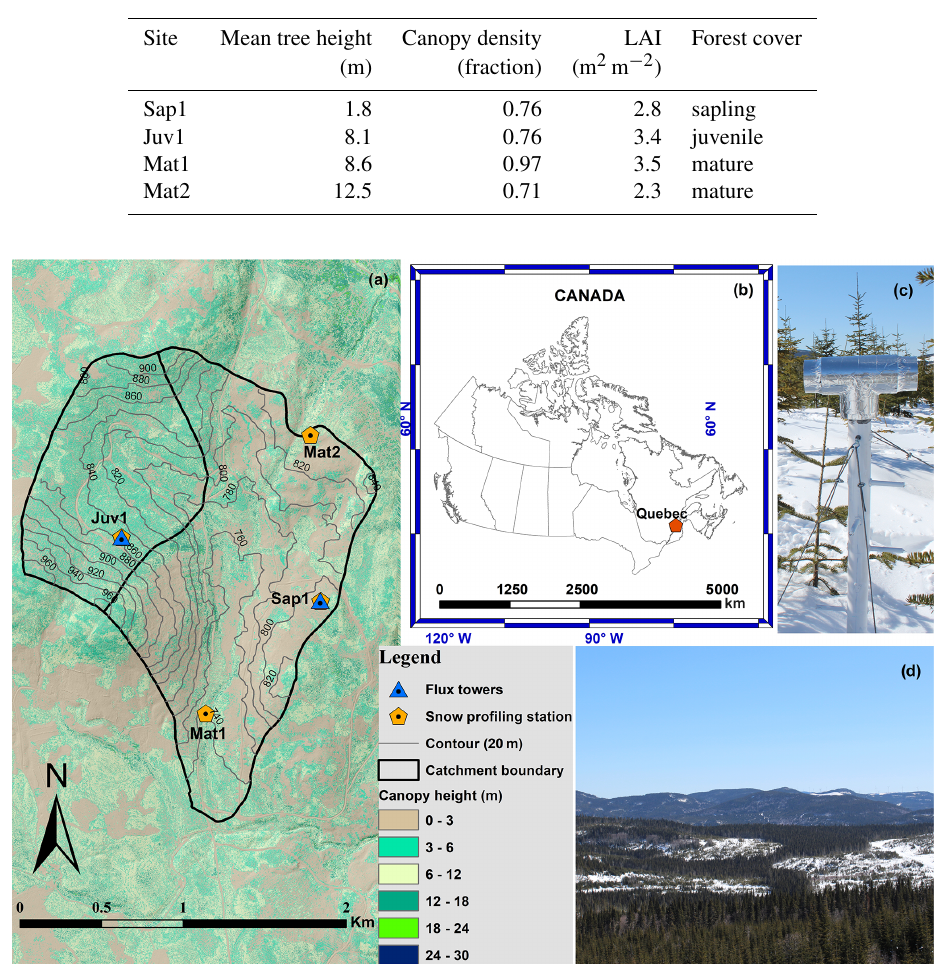
Figure 1. Overview of the study area. (a) Basin 7 within BEREV showing the locations of the four study sites (note that elevations are in metres), where snowpit samples were collected and snow-profiling stations were installed, (b) the location of BEREV in eastern Canada, (c) the snow-profiling station installed at site Sap1, and (d) typical winter conditions at BEREV as seen from the flux tower at site